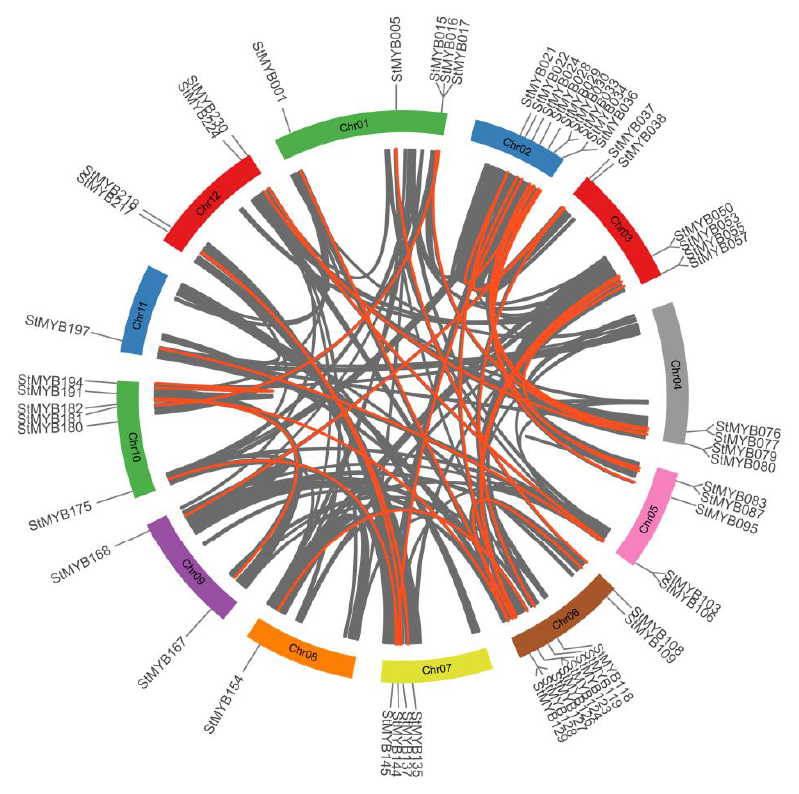
Figure 5. Segmental duplication events and inter-chromosomal relationships between StMYB genes. The 31 putative segmental duplication pairs of StMYB genes were investigated with MCScanX and linked by the colored lines, respectively. The gray lines indicate all putative segmental duplication pairs in the potato genome.